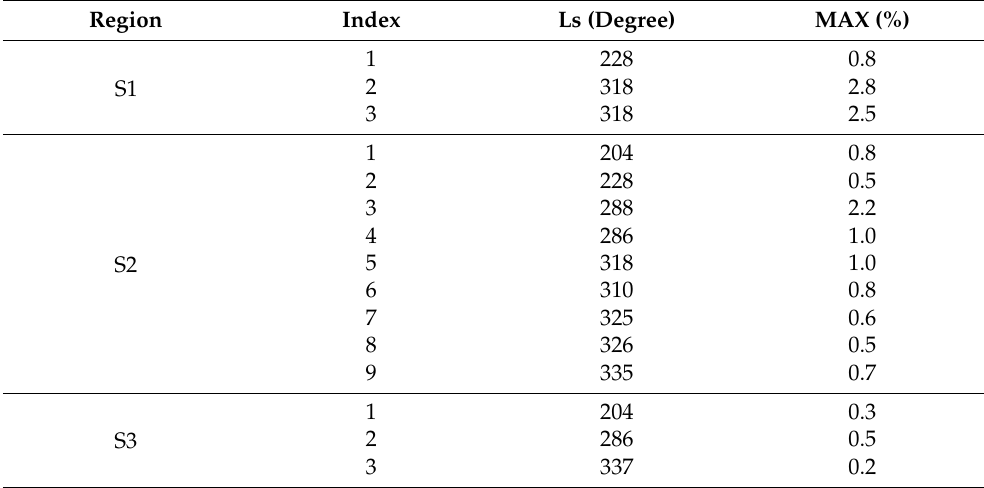
Table 4. The maximum value (MAX) of the roughness in the summer/spring season of study regions. The elevation data were generated with CTX image pairs, the indices of which are listed in Supplementary Table S1.